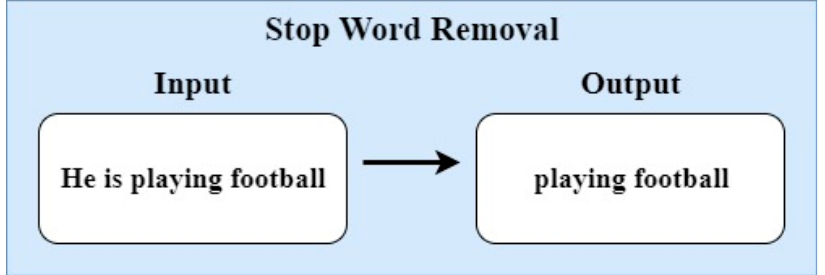
Figure 5. Sample text after stop word removal.